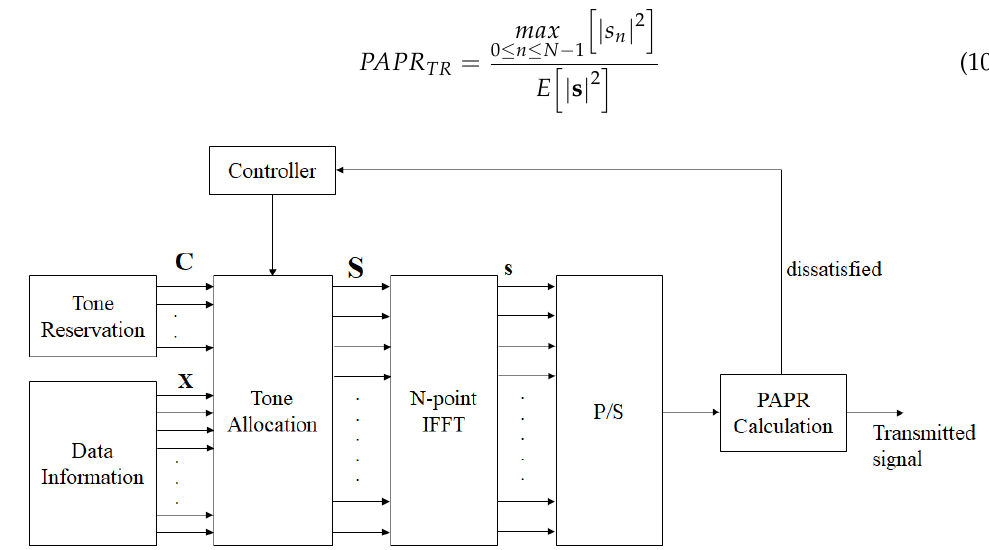
Figure 6. The block diagram of the TR scheme in OFDM systems.